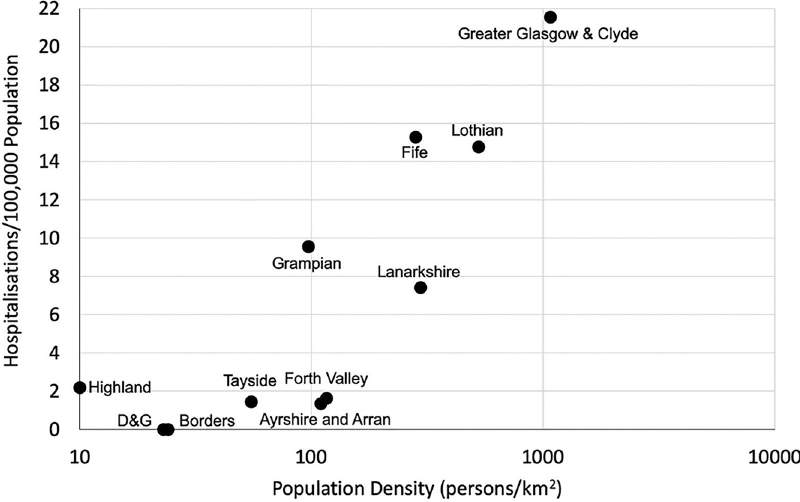
Fig 3. Confirmed COVID-19 hospitalisation rates/100,000 versus population density in all 11 Scottish mainland health boards on 14th June 2020. Similar graphs showing data for the five other time points are available on request. The graph is shown with a logarithmic axis for